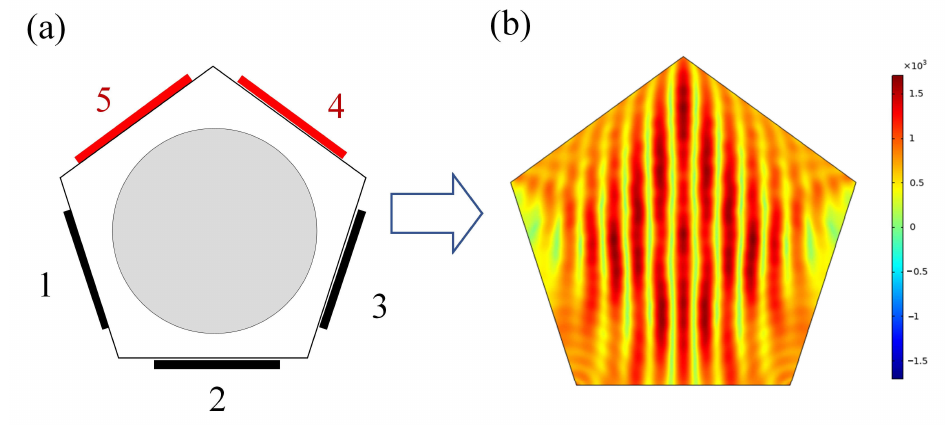
Figure 5. Adjacent excitation mode (AEM): ( a ) sound source configuration and ( b ) sound pressure distribution map.